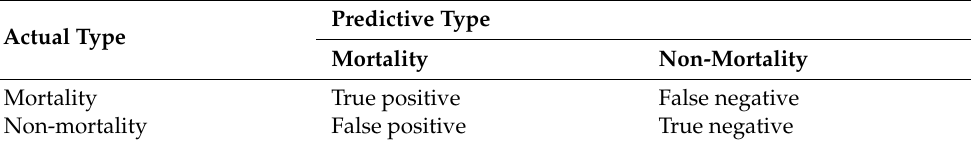
Table A5. Confused matrix of random forest model.